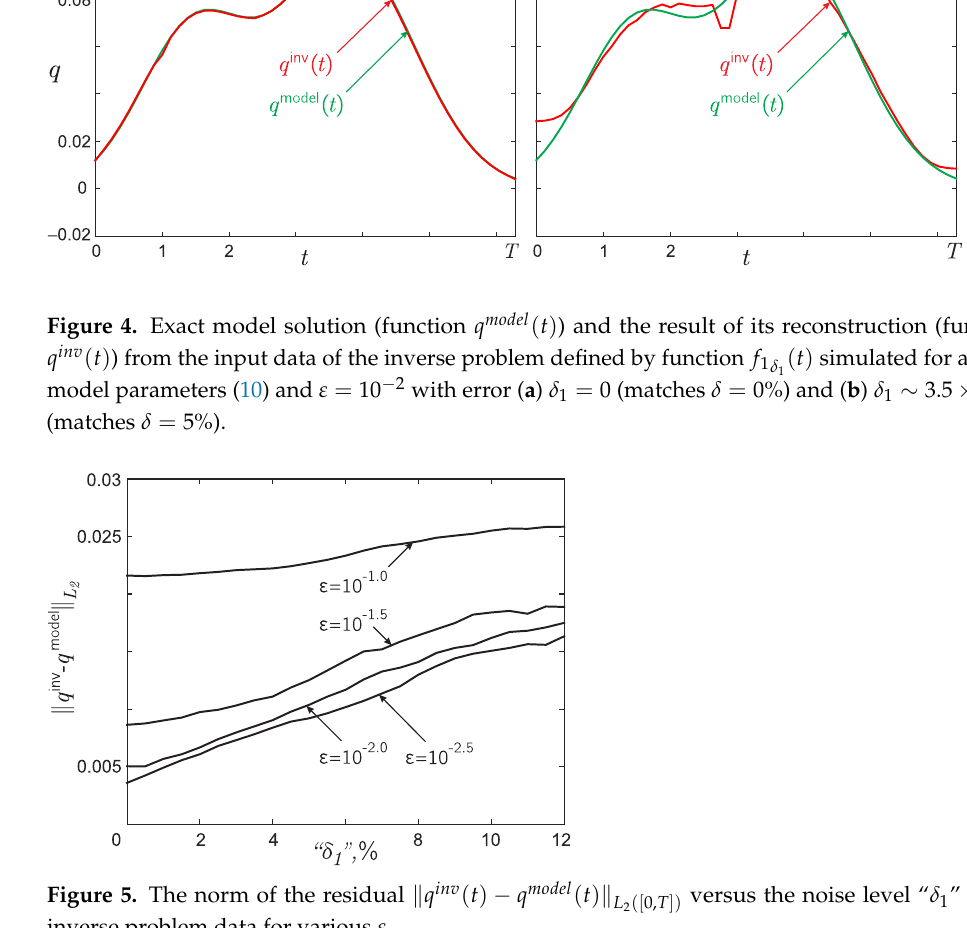
versus the noise level “ δ 1 ” of the 2 ([ 0, T ])